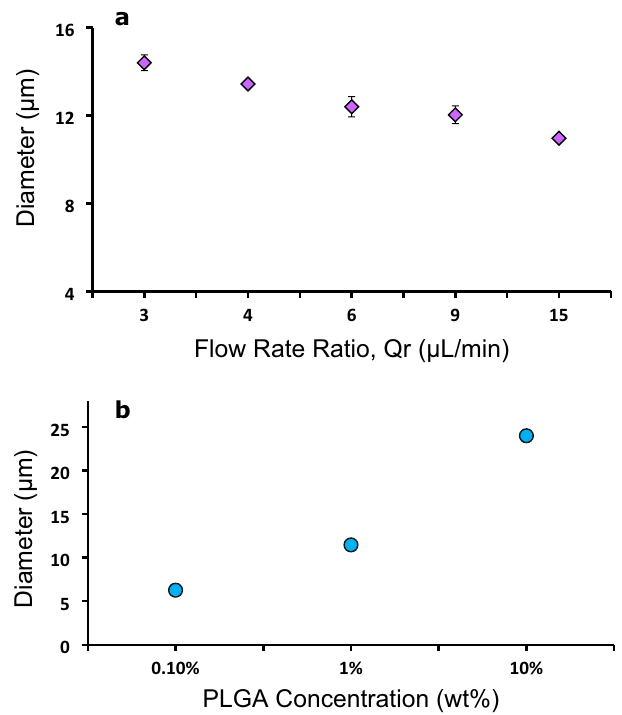
Figure 4. Microfluidic modulation of particle size. ( a ) Microparticle size range generated using 1 wt% PLGA at different flow rates. Q r is the flow rate ratio of continuous to dispersed phase. ( b ) Modulation of particle diameter using various concentrations of PLGA at a Q r of 9. n ≥ 3 experiments for ( a ) and ( b